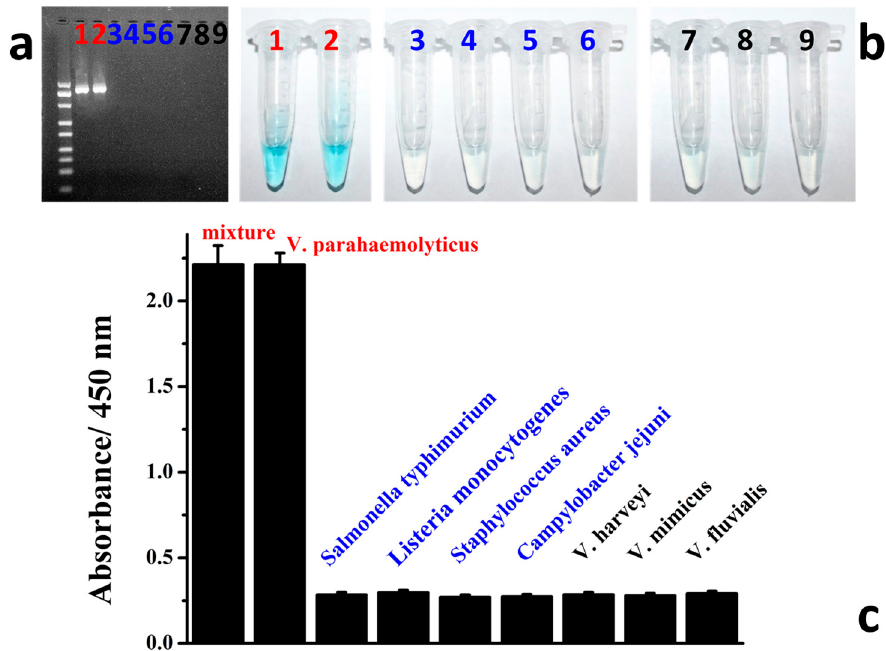
Figure 4. Specificity integration results of V. parahaemolyticus detections. Based on the specific designed primer set, both the gel electrophoresis and colorimetric methods demonstrated excellent specificity for V. parahaemolyticus detections. Agarose gel analysis ( a ) of amplified PCR products and colorimetric response ( b ). Absorbance ( c ).